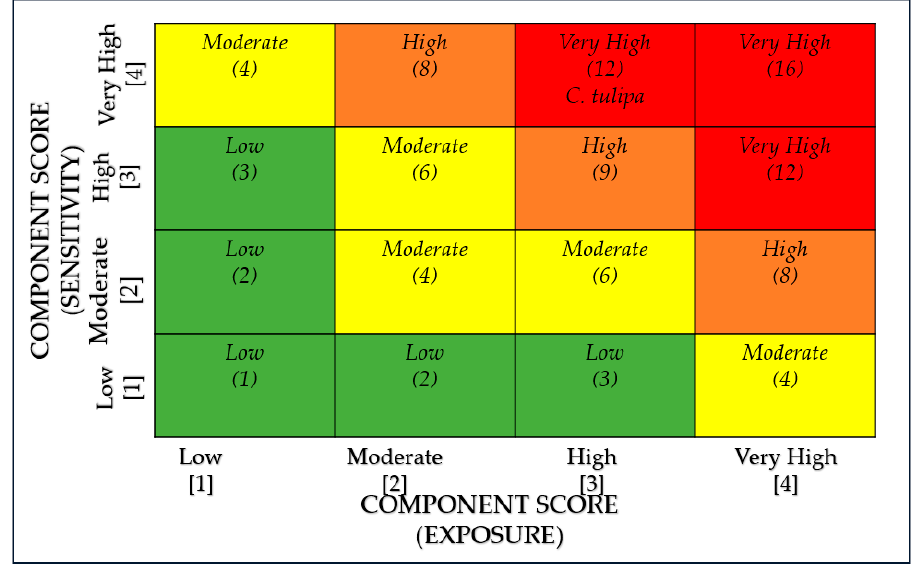
Figure 4. Vulnerability matrix showing the vulnerability region of C. tulipa estimated from sensitivity and exposure scores.